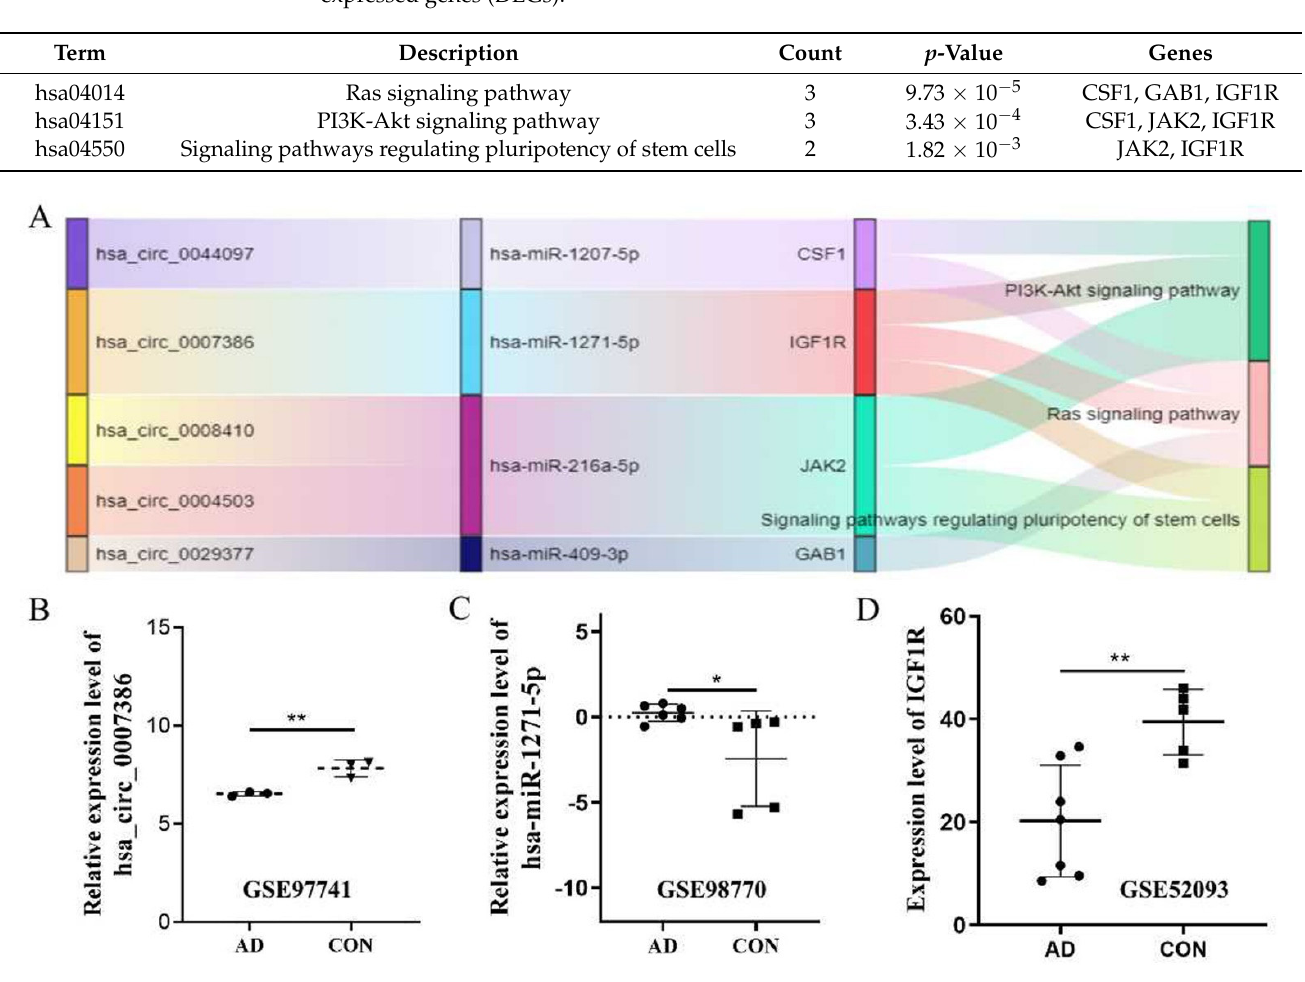
Figure 6. Signal axis screening and specimen verification. ( A ) Sankey diagram for the circRNA-mi- croRNA-mRNA-pathways axis screened out in this study. Each rectangle represents a gene or path- way, and the connection degree of each gene is visualized based on the size of the rectangle. ( B – D ) The expression levels of the hsa-cic-0007386/miR-1271-5P/IGF1R between the TAD and CON group in the GSE97745, GSE98770, and GSE52093 datasets, respectively. * p < 0.05, ** p < 0.01. ( E – G ) The expression levels of the hsa-cic-0007386/miR-1271-5P/IGF1R between the TAD and CON group in our aortic dissection specimen. * p < 0.05, ** p < 0.01.